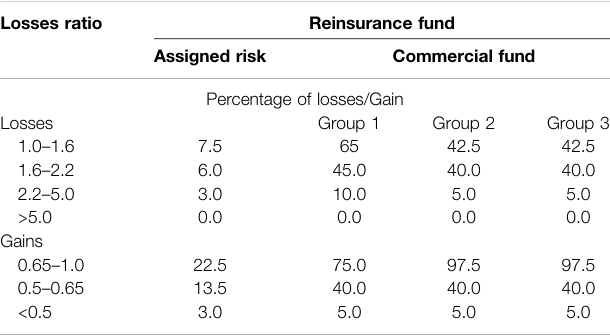
TABLE1| Sharesofunderwritinggainsandlossestoinsurancecompaniesunder the 2021 Standard Reinsurance Agreement. Losses ratio Reinsurance fund Assigned